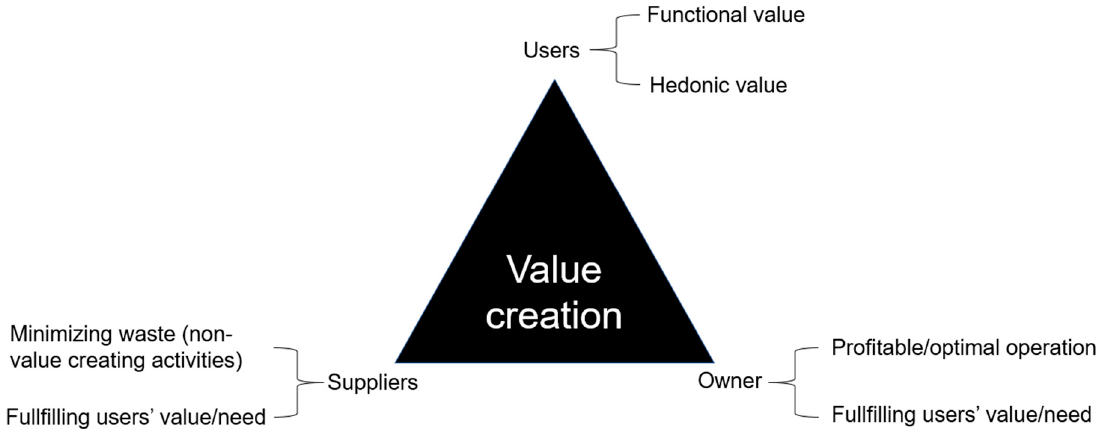
Figure 1. Main stakeholders’ requirements for value creation [20].